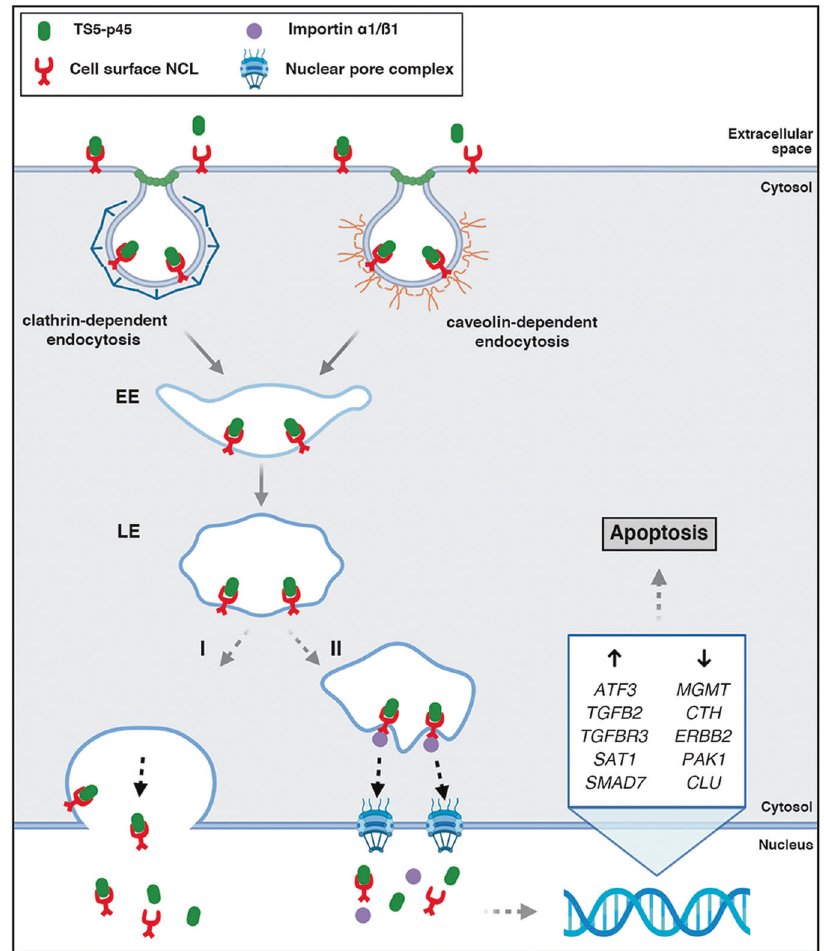
Fig. 8 A schematic illustration of the pro-apoptotic mechanism of action of TS5-p45 in ECs. Upon binding to its cell surface receptor NCL, TS5-p45 gets internalized through clathrin- and caveolin-dependent endocytosis and traf fi cked to LEs. Thereafter, two possible mechanisms may be involved in the nuclear traf fi cking of TS5-p45. I LEs shuttle the NCL-TS5-p45 complex to the nucleus via fusion with the nuclear envelope. II NCL-TS5-p45 complex is transported to the nucleus by a process involving importin α 1/ß1. TS5-p45-treated ECs